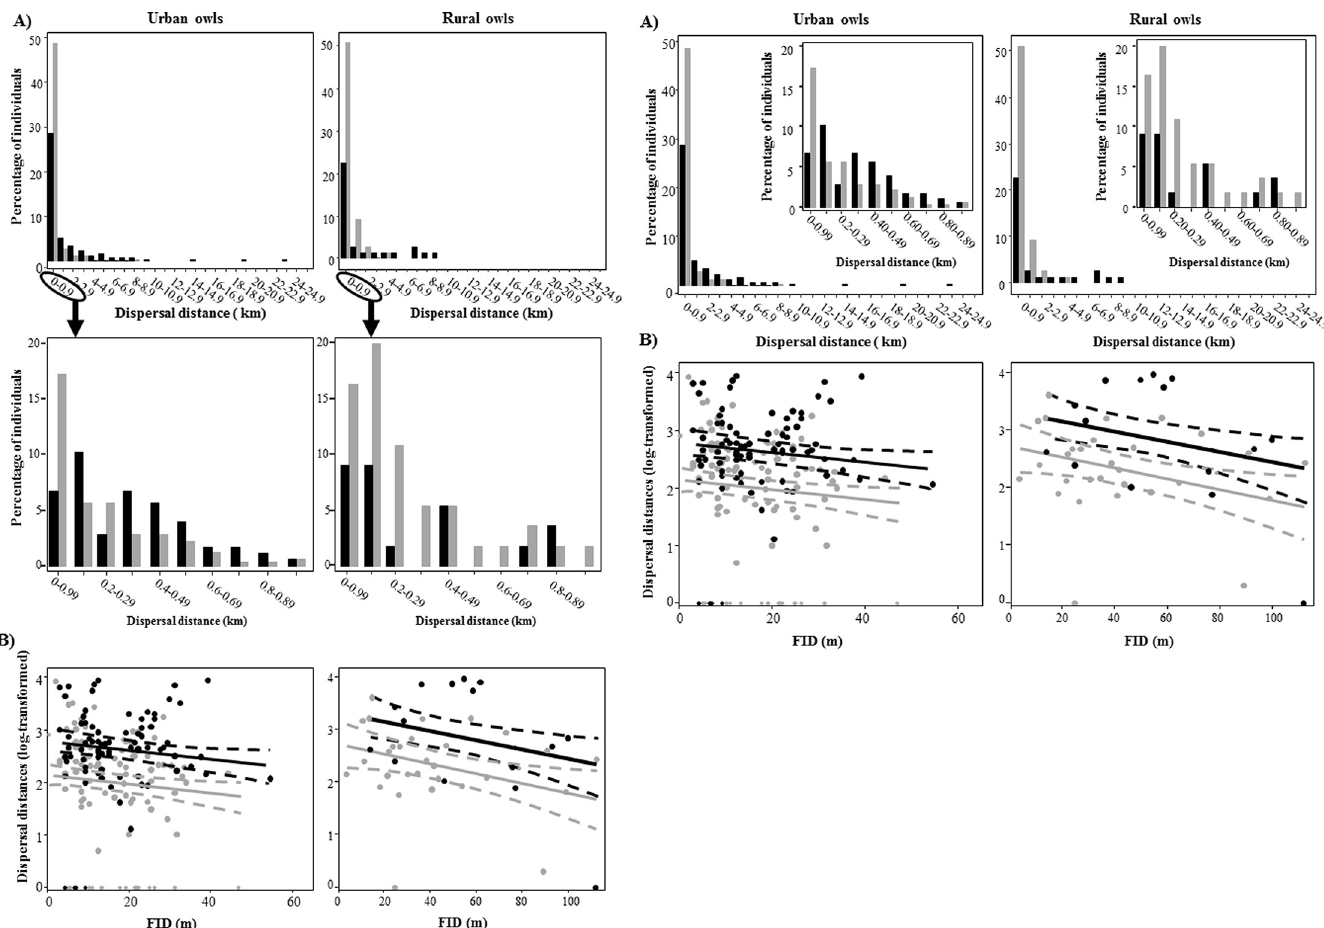
Fig 1. A) Natal dispersal distances of urban and rural burrowing owls Athene cunicularia (males: gray bars; females: black bars). The inserted figure shows a detailed distribution of dispersal distances lower than 1km. B) Relationship between natal dispersal distances (log-transformed) and individual personality (measured as FID, flight initiation distance). Lines show the tendency observed for males (gray line) and females (black line). Dashed lines represent the 95% confidence interval. Dots are raw data (males: gray dots, females: black dots).